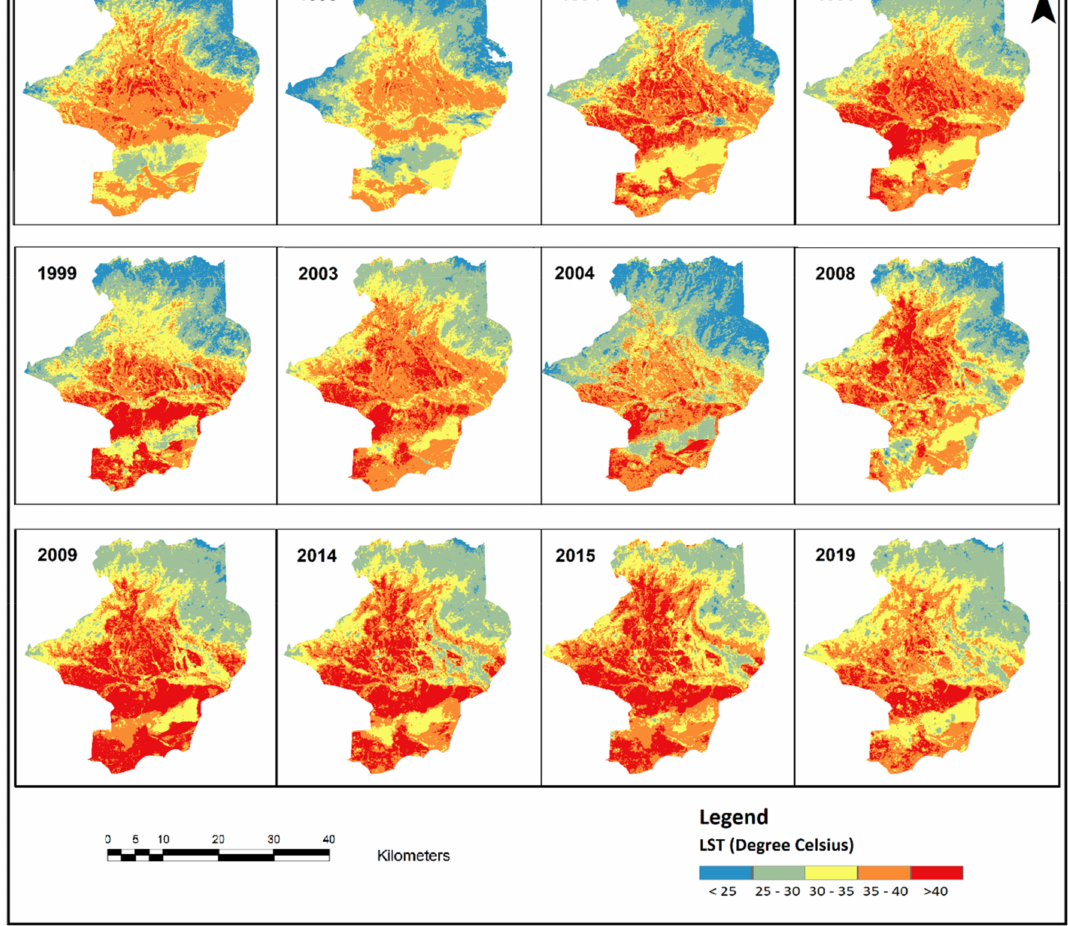
Figure 5. LST ( ◦ C) maps for selected years between 1989 and